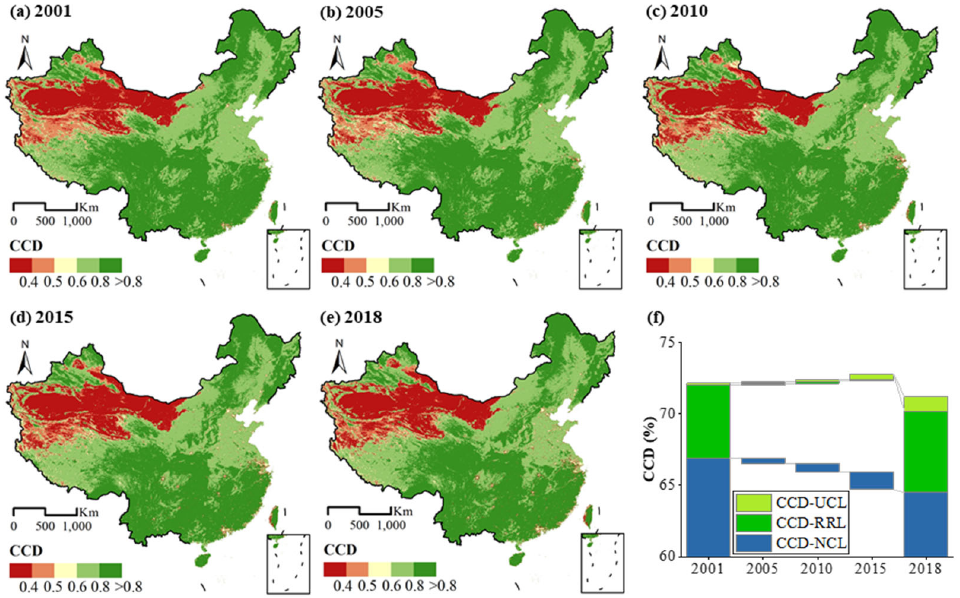
Figure 5. Annual CCD in China from 2001 to 2018. ( a ) 2001; ( b ) 2005; ( c ) 2010; ( d ) 2015; ( e ) 2018; ( f ) CCD change of China of UCL,RRl and NCL from